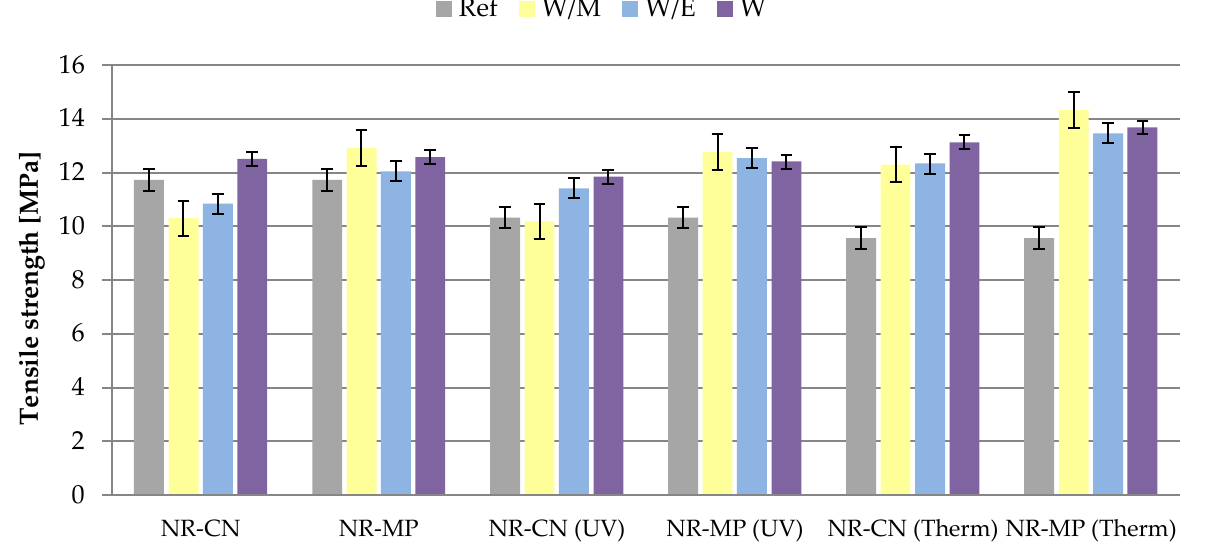
Figure 10. Results of tensile strength measurements of unaged samples, after ultraviolet (UV) and thermo-oxidative (Therm) aging.